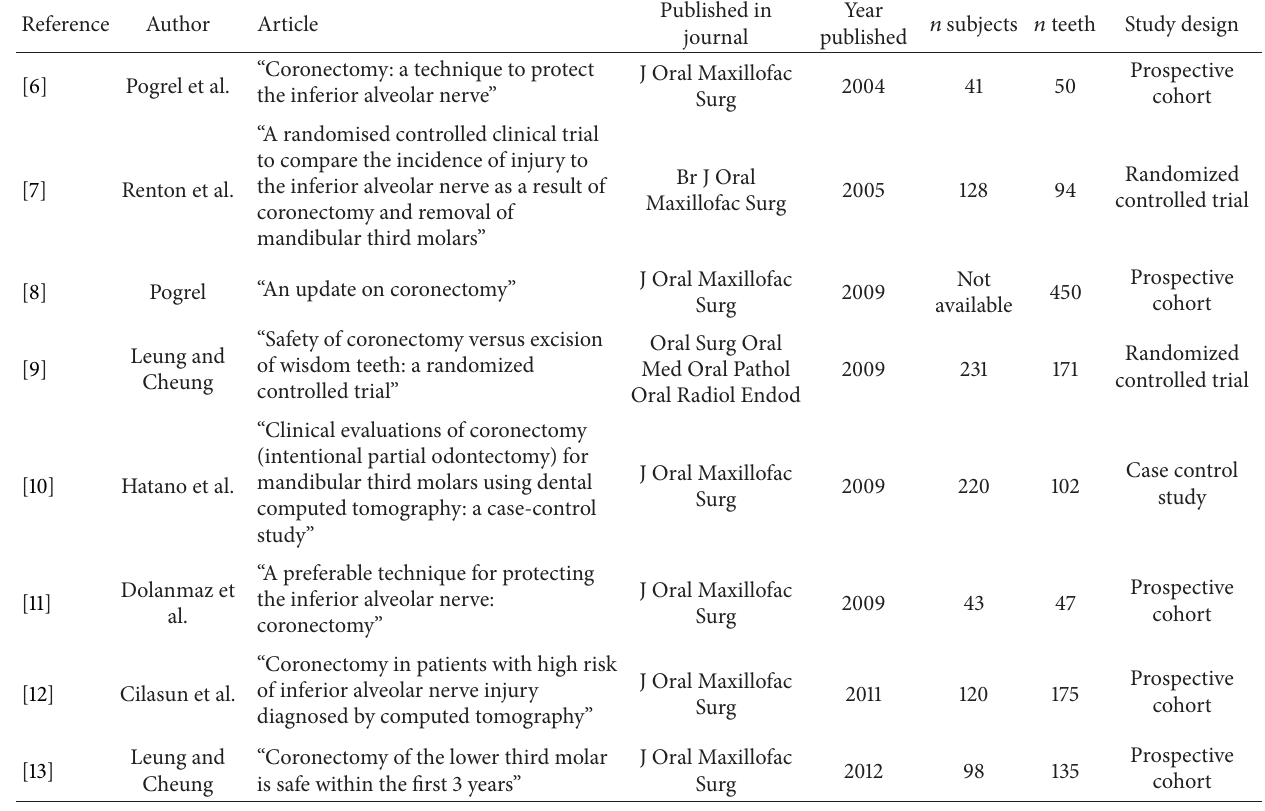
Table 1: Published prospective